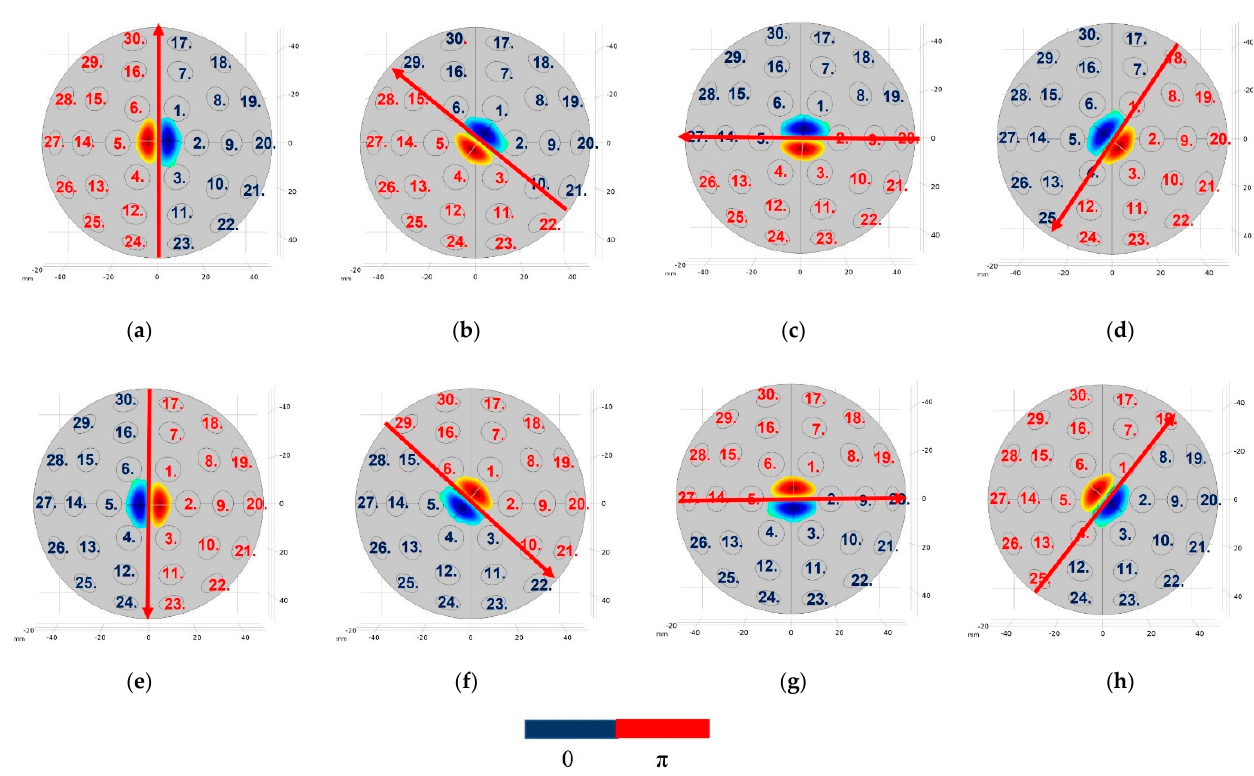
Figure 4. Twin phase information for each transducer in the array rotated along the Z -axis: ( a ) 0 ◦ ; ( b ) 45 ◦ ; ( c ) 90 ◦ ; ( d ) 135 ◦ ; ( e ) 180 ◦ ; ( f ) 225 ◦ ; ( g ) 270 ◦ ; and ( h ) 315 ◦ . Second, the rotation was demonstrated on the O-XZ plane or O-YZ plane (roll motion) with a reference coordinate of array. Each side of tweezer was excited with a different power supply. The custom switching power circuit was made to switch power to each side of the array. This method allowed us to control the excitation voltage reaching each side of the tweezer to within the 10–60 Vpp range independently. We found that the cylinder in the twin trap could go up or down following the excitation voltage. This phenomenon is ideal for reconfiguring the two cylinders in the tweezer to rotate trapping objects along the X -axis. Based on the proposed method, we ran the simulation in COMSOL Multiphysics with the excitation voltage different between two side of tweezer from 10 V to 50 V. Figure 5a,b show the normalized acoustic field and radiation force value at the physical focal point of the proposed array (0, 0, 0) with reference to the case excitation voltages for both sides of the system are 60 Vpp. Till date, this method has not been reported, theoretically or experimentally, in both acoustics and optics.